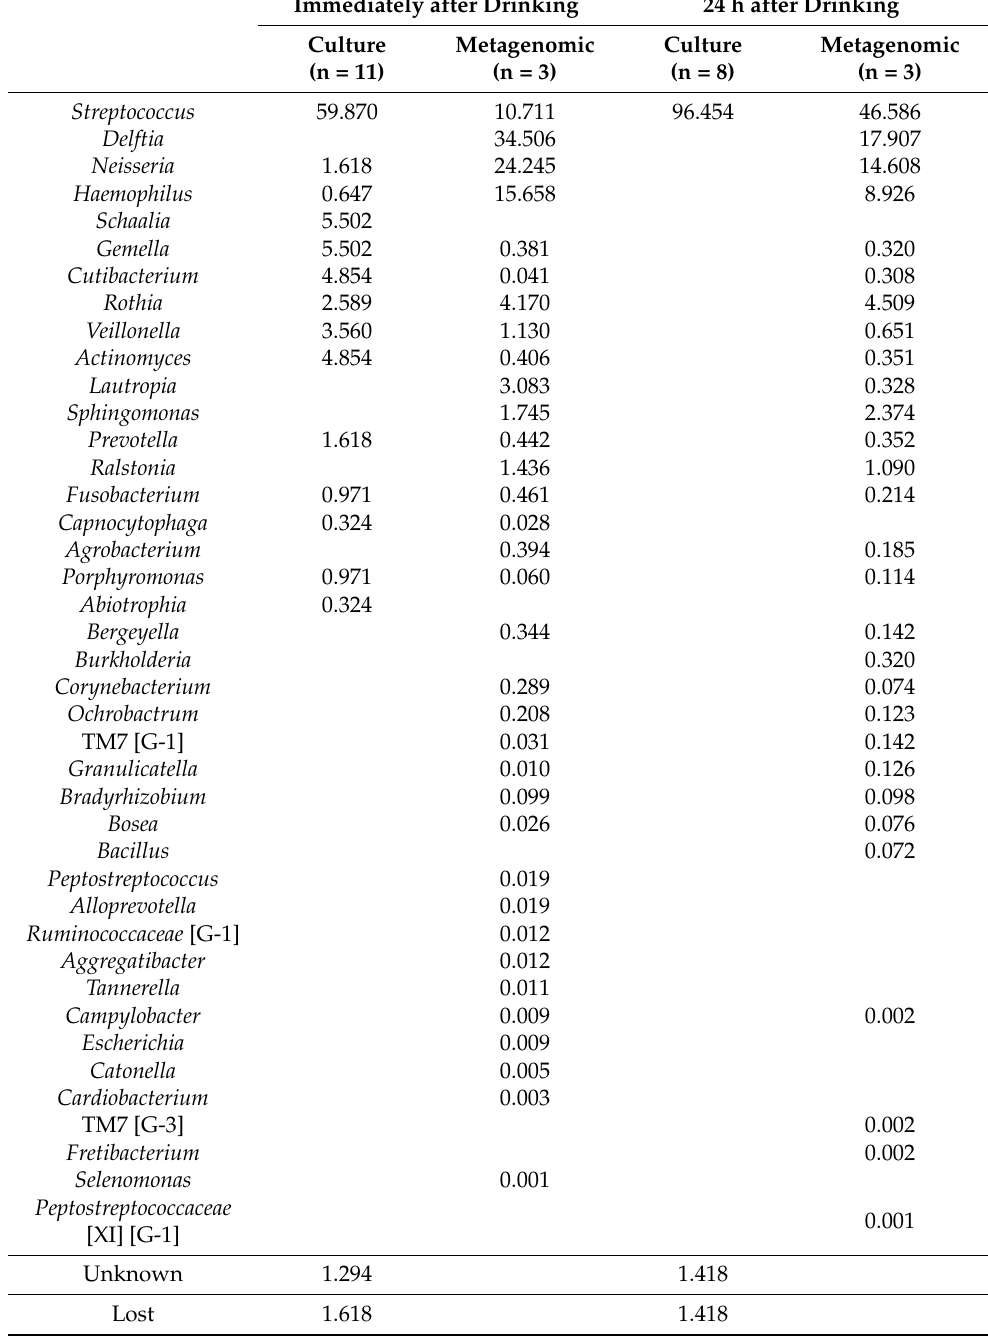
Table 2. Culture and metagenomic analyses of the bacterial compositions (percentages) at the mouth of plastic bottles immediately after and 24 h after